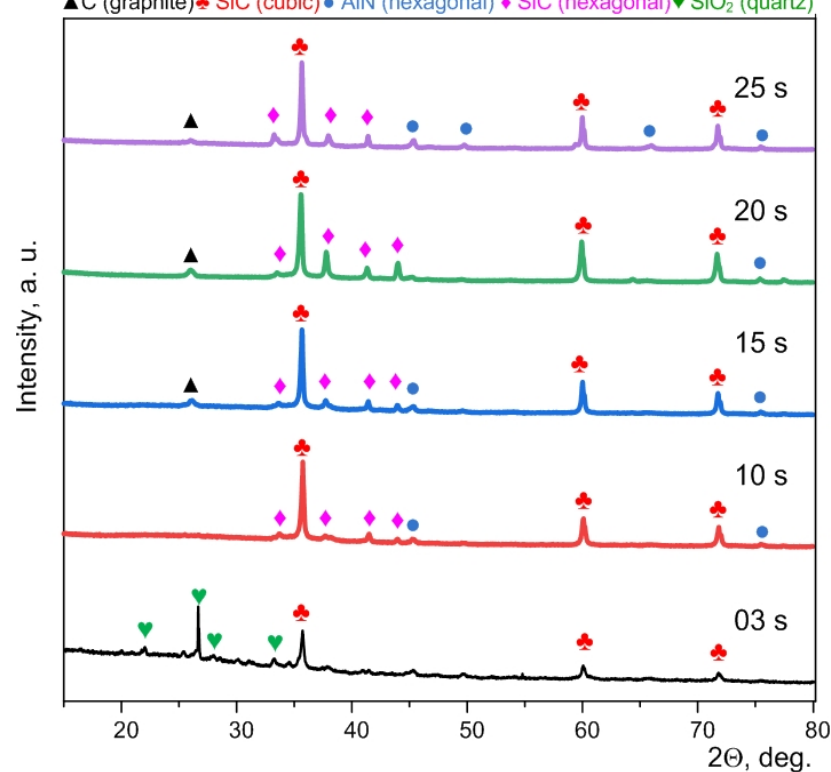
Figure 3. XRD patterns of the synthesized products purified from excess carbon and obtained at different times. different